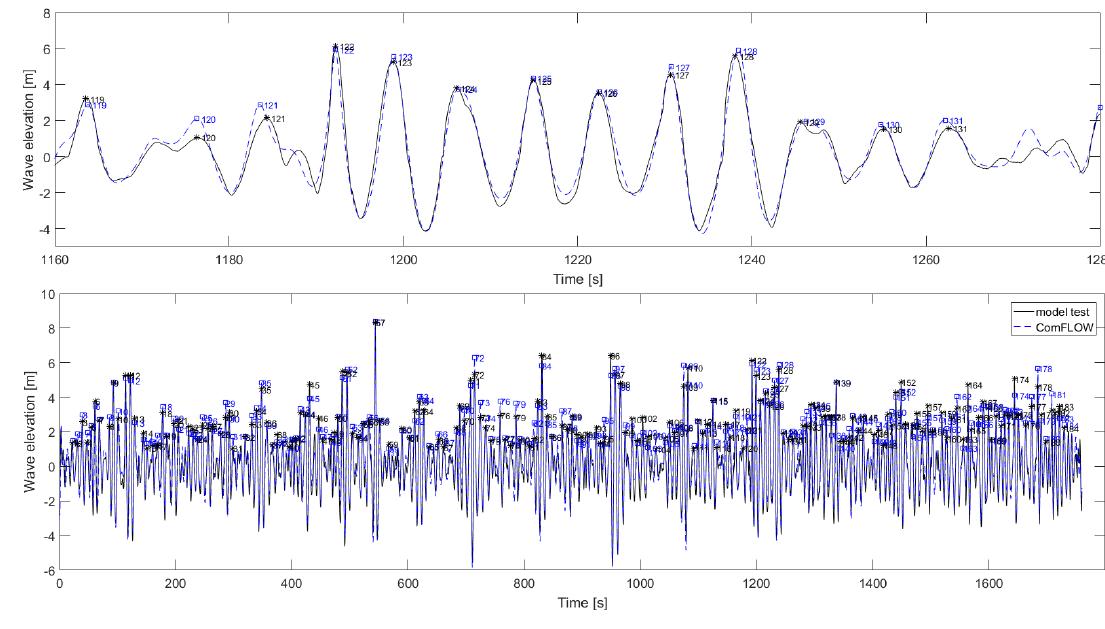
Figure 11. Measured and simulated wave elevation at probe W15.